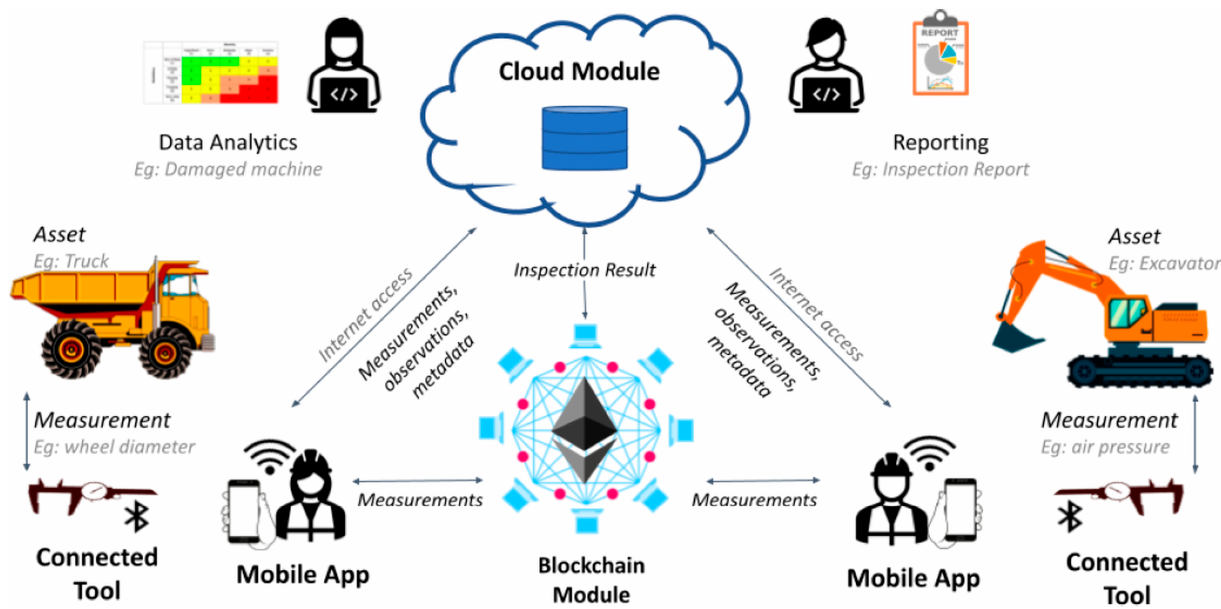
Figure 13. High-level architecture of Integrating the IoT and Blockchain Technology in the mine inspection (Reprinted from Ref. [79]).